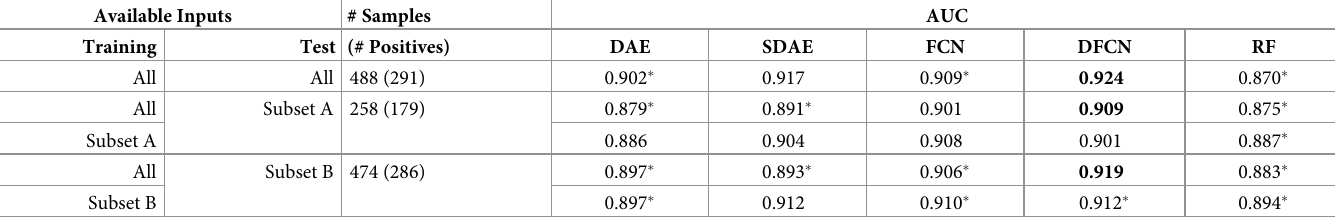
Table 3. Comparison of models on the test dataset from a different institution using specific input subsets (subsets A and B) selected for clinical/cost reasons. The top section indicates the benchmark performance when both training and test-sets include all inputs. In the central section performance on test-data with only subset A of inputs is shown. Models are trained with all inputs and with only subset A of inputs. The lower section of the table repeats these experiments for subset B. Bold font indi- cates the highest AUC value in the table section. � indicates AUCs that are significantly lower than the highest in that section ( p < 0.05). Available